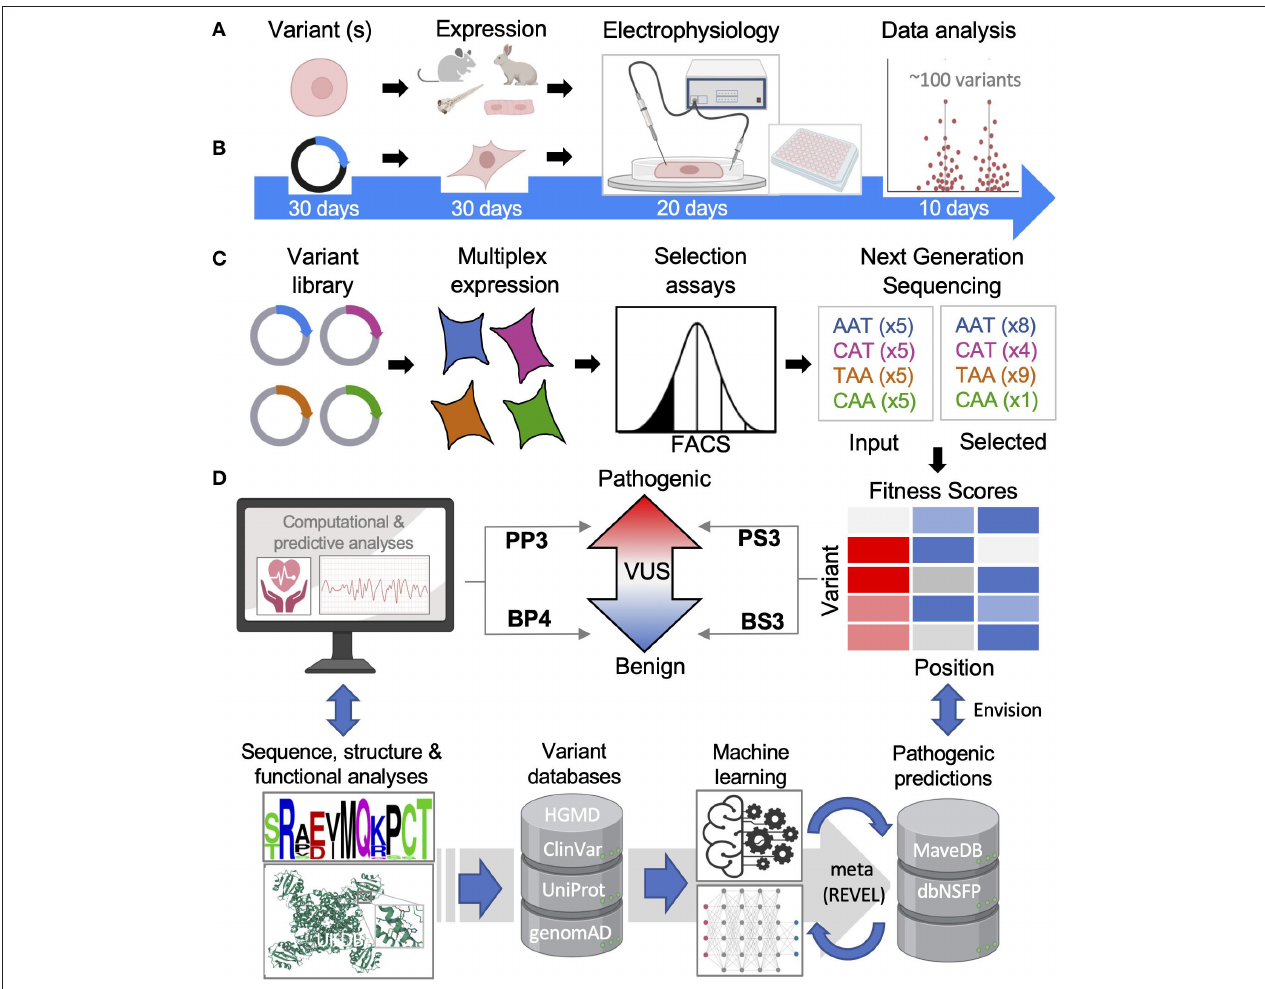
FIGURE 4 | Functional and computational methods of inherited cardiac arrhythmias. (A) Animal and iPS-CM functional models will remain important but are low throughput. (B) Overexpression systems are higher throughput especially when automated with functional results for ∼ 100 variants reported in less than two months’ time by Ng et al. ( 38). (C) Multiple assays of variant effects (MAVEs), while largely proxy assays, are magnitudes higher throughput allowing for comprehensive variant analyses. (D) Tools to predict a VUS can be simple and rule-based relying on sequence and/or structural data or, more commonly, machine learning methods are employed. FACS, fluorescence-activated cell sorting; HGMD, Human Gene Mutation Database; UniProt, Universal Protein Resource; genomAD, Genome Aggregation Database; REVEL, Rare Exome Variant Ensemble Learner; dbNSFP, Database for Functional Predictions of non-synonymous